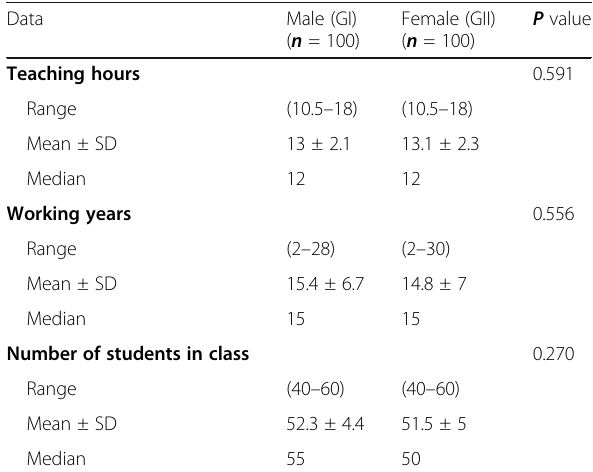
Table 3 Comparison between male and female teachers regarding classroom factors